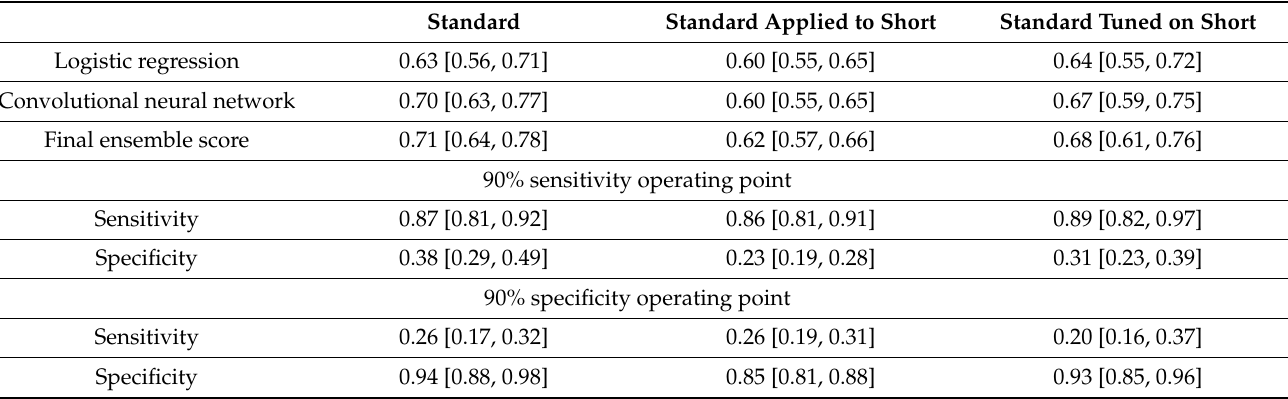
Table 3. Performance summary of the AI system.